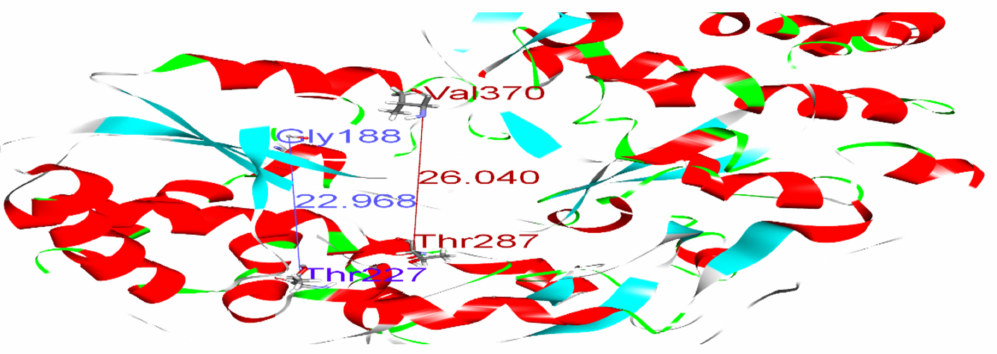
Figure 4. Distances between Gly188 and Thr227 (blue), and between Thr287 and Val370 (dark red), in the wild-type model.